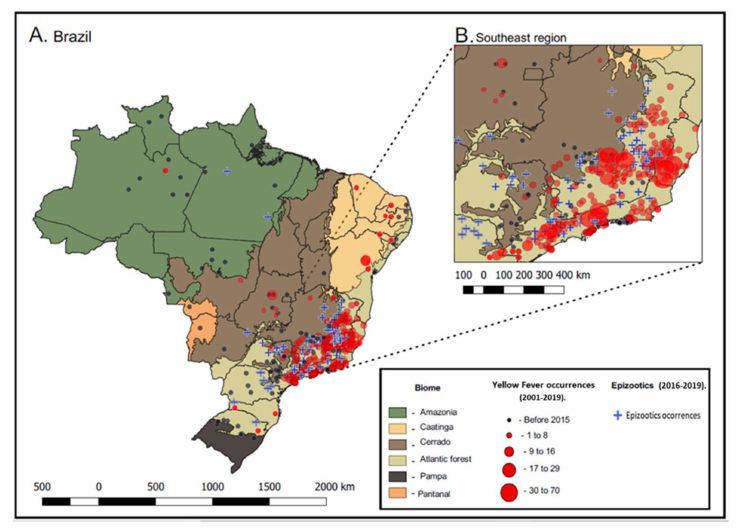
Figure 2. Spatial distribution of Yellow Fever (YF) cases in Brazil during 2001–2019. The map shows a correlation between human confirmed cases of YF and biomes ( A ), and confirmed epizootics in the Southeast region ( B ) during the 2016–2019 outbreak. The map was created using the Quantum GIS (QGIS)